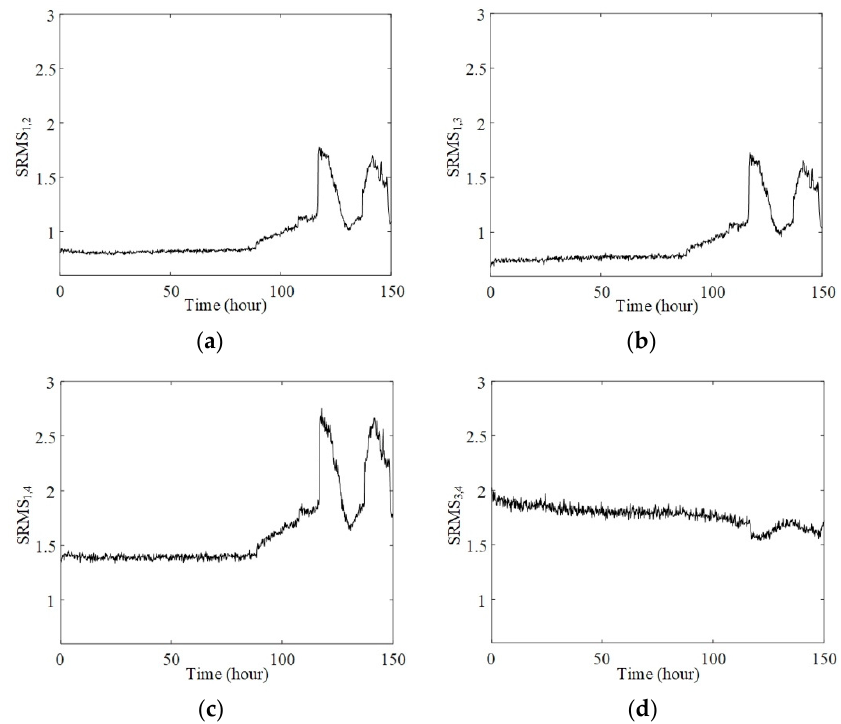
Figure 10. Synchronized root mean square index between ( a ) bearings 1 and 2; ( b ) bearings 1 and 3; ( c ) bearings 1 and 4; ( d ) bearings 3 and 4.